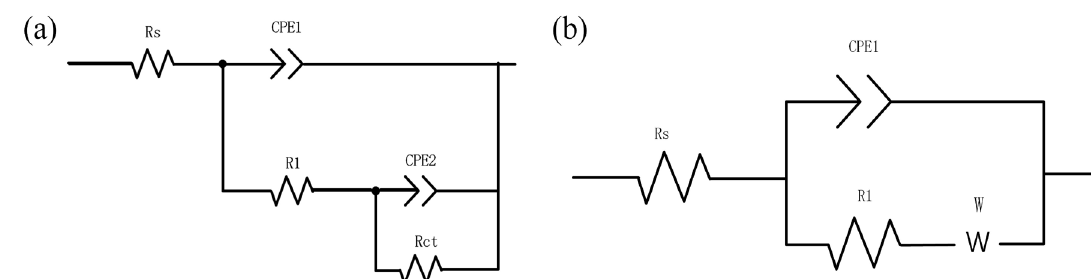
/Ni-P coatings, (b) duplex Ni-P-50mL/L TiO 2